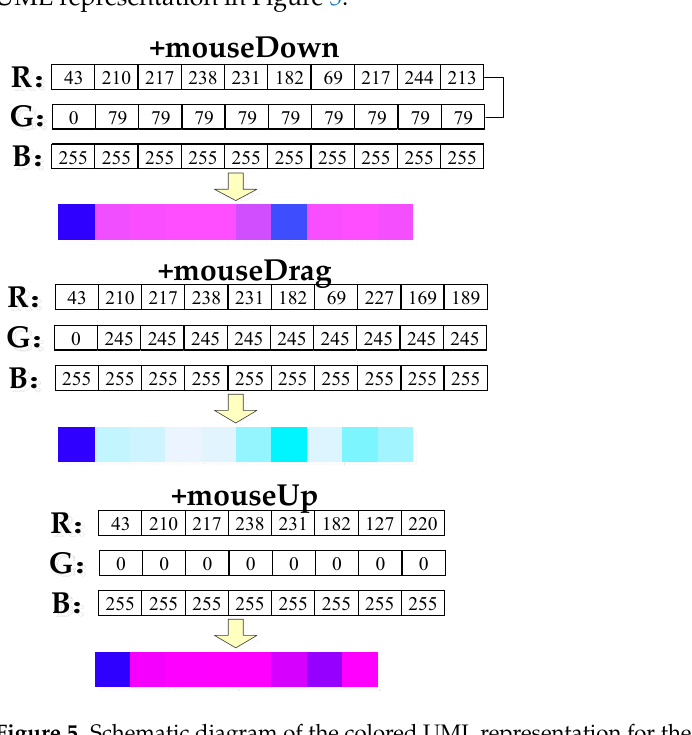
Figure 5. Schematic diagram of the colored UML representation for the operation names of the three operations of the class Selection Tool.